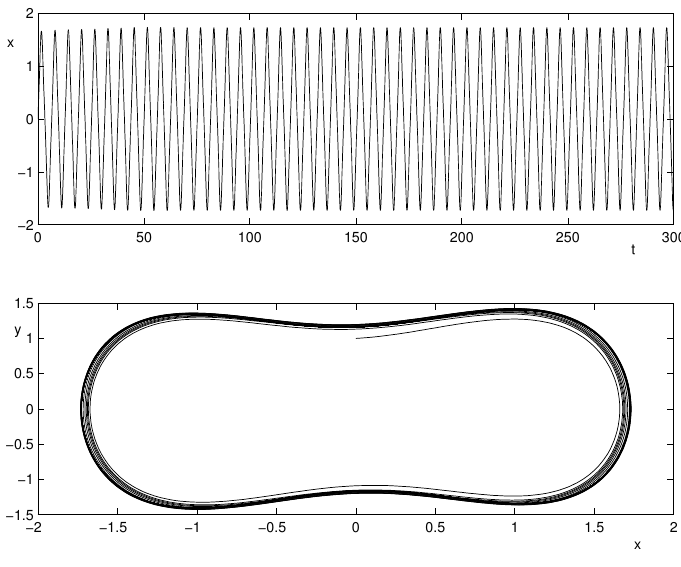
Figure 8. Adapted Duffing system ( a = 0 .